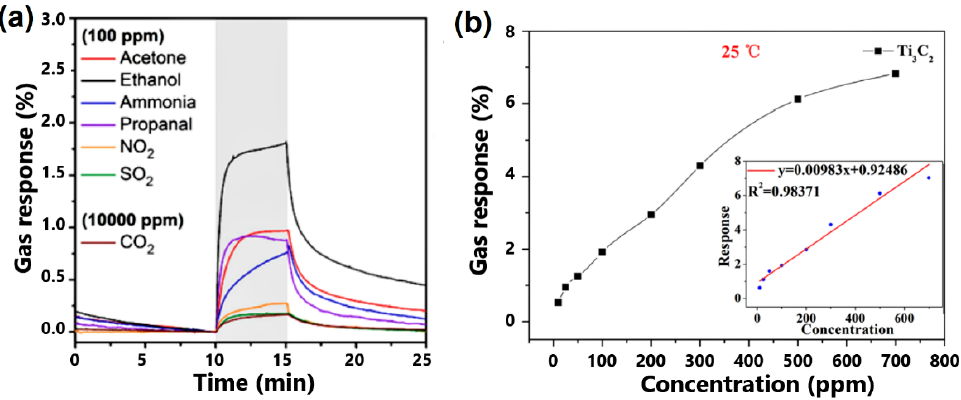
Figure 11. ( a ) Gas sensor response of Ti 3 C 2 T x MXene to different gases at the concentration of 100 ppm at room temperature. Reprinted with permission from [6]. Copyright © 2018, American Chemical Society. ( b ) Gas sensor response of Ti 3 C 2 MXene to different NH 3 concentrations at room temperature. Reprinted with permission from [81]. Copyright © 2019, American Chemical Society.